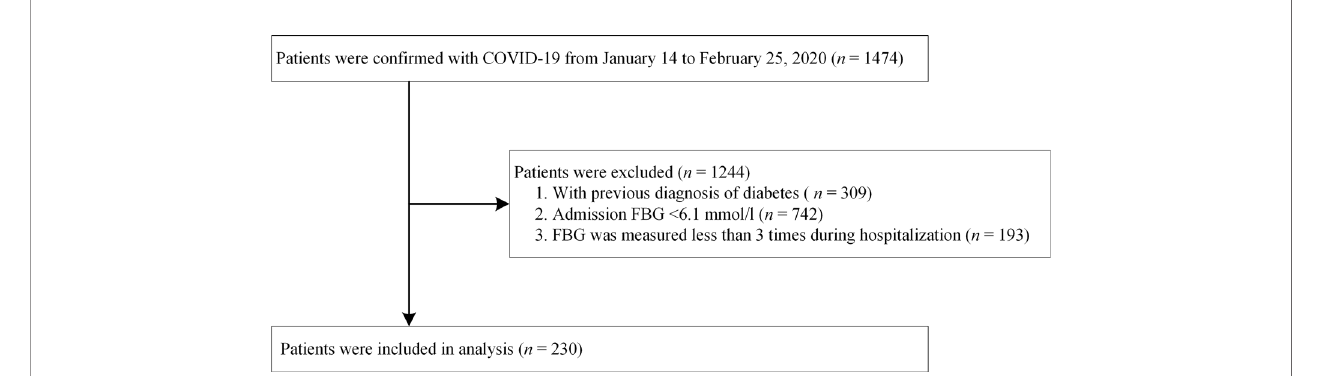
FIGURE 1 | Flowchart of patient